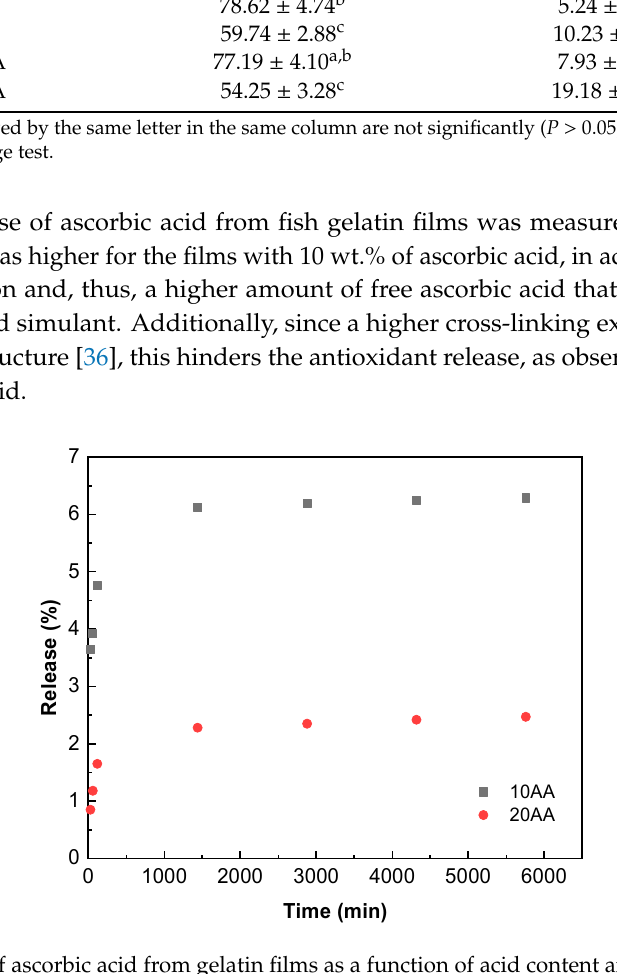
Figure 4. Release of ascorbic acid from gelatin films as a function of acid content and immersion time.